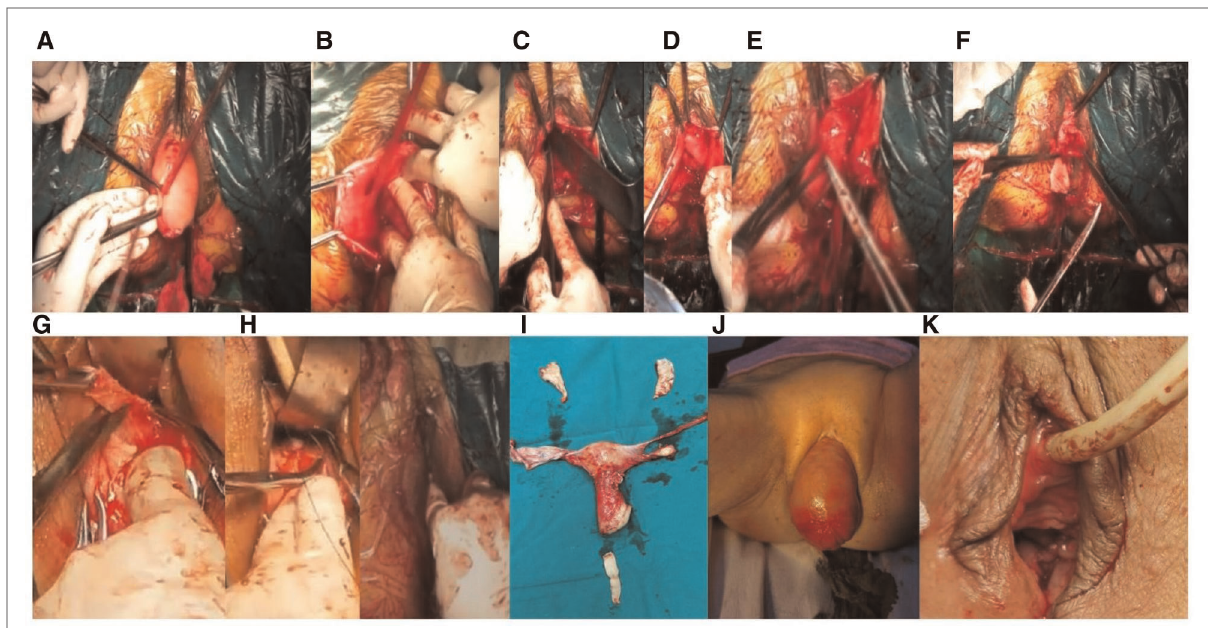
FIGURE 2 Intraoperative pictures of patients in the observation group. ( A ) After hysterectomy, the vaginal mucosa in front of the bladder is incised; ( B ) the vaginal bladder space is separated by an anterior approach to the ischial spine and the fascia 1 cm above it; ( C ) nonabsorbable suture are used to suture the ischial spine fascia; ( D ) pull the suture and try to pull the force; ( E ) the other end of the suture is fi xed on the inner vaginal fascia, do not penetrate the vaginal mucosa, and the suture is not knotted temporarily; ( F ) trim part of the anterior vaginal wall mucosa and purse-string suture the bladder; ( G ) trim part of the posterior vaginal wall to the top of the vaginal fornix; ( H ) suture the posterior wall of the vagina, narrow and fasten the vagina; ( I ) after the anterior and posterior walls of the vagina are sutured, the sciatic fascia sutures and the sutures at both ends of the vaginal fascia are knotted to fi x the sutures at both ends of the vaginal fascia to lift the vaginal vault; ( J ) whole uterus, part of vaginal wall specimen; ( K ) preoperative photo of pelvic organ prolapse; ( L ) postoperative